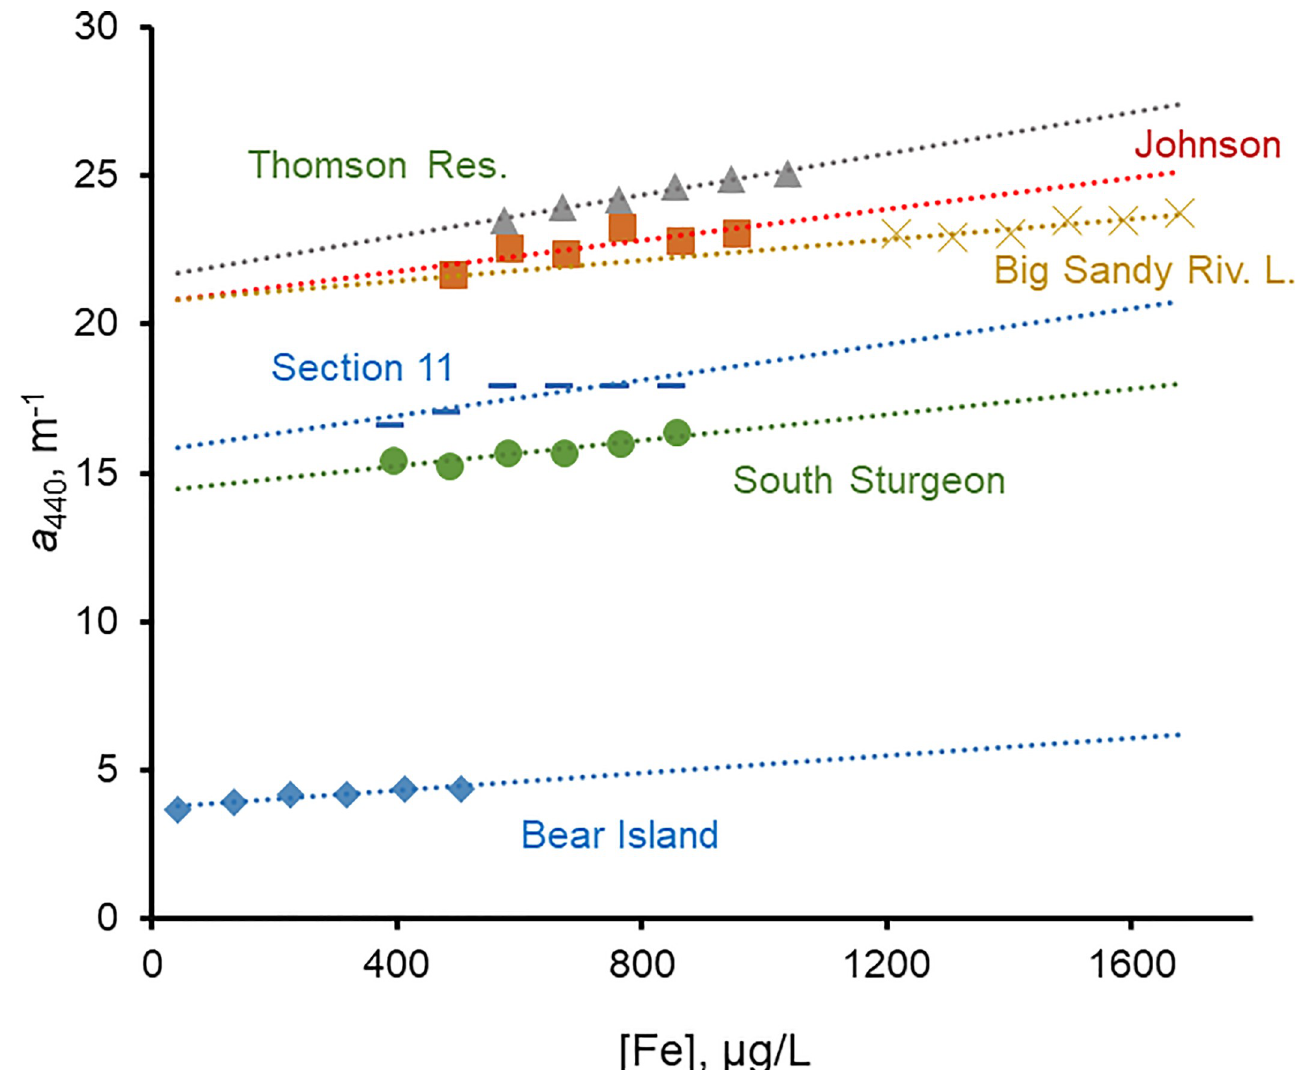
Fig 6. a 440 vs. Fe diss for six waters in iron addition experiment; slopes and statistical information on best-fit lines in Table